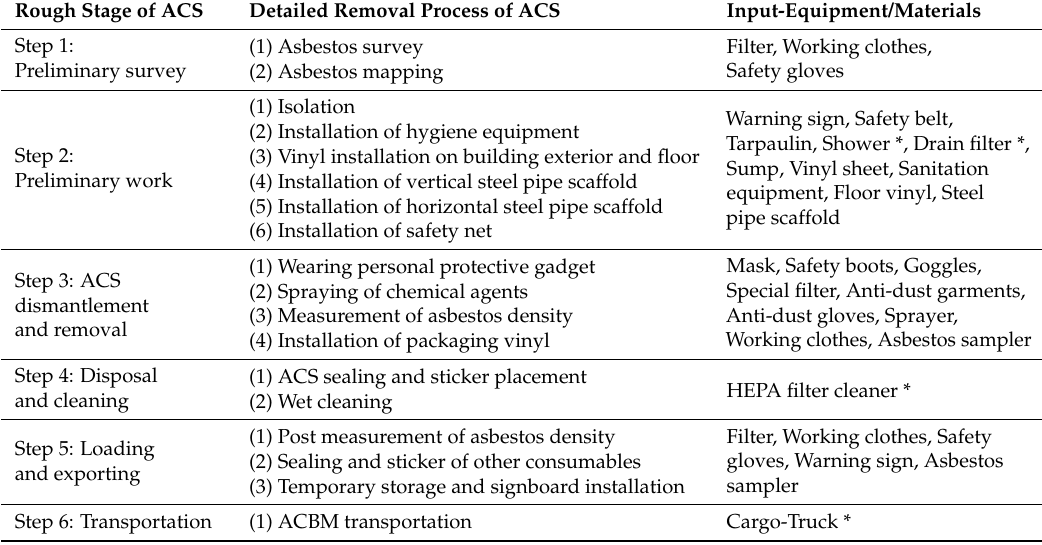
Table 2. Input-equipment inventory for each ACS removal